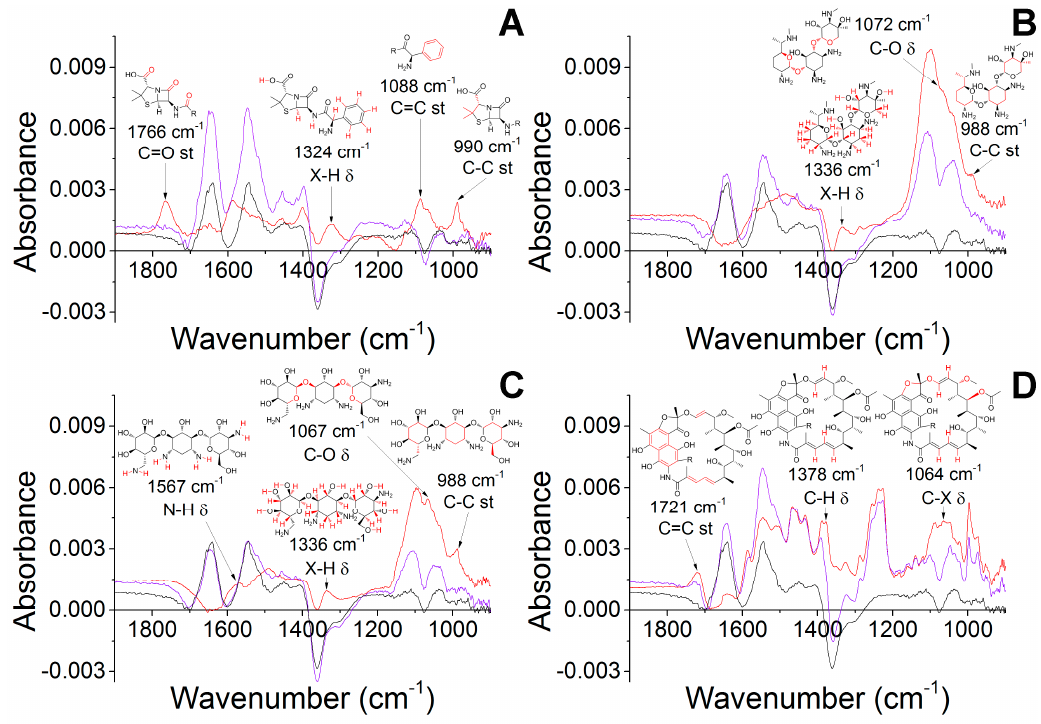
Figure 6. Fourier ‐ transform infrared (FTIR) spectra of the studied samples. Violet line is for the enzyme, red is for the antibiotic, the black is for the antibiotic and enzyme (1:1). Concentration of each component in the samples was 1 g ∙ L − 1 : ampicillin—2.9 mM ( A ); gentamicin—2.1 mM ( B ); kanamycin—2.1 mM ( C ); and rifampicin—1.2 mM ( D ); His 6 ‐ OPH—14 μ M. Localization of some